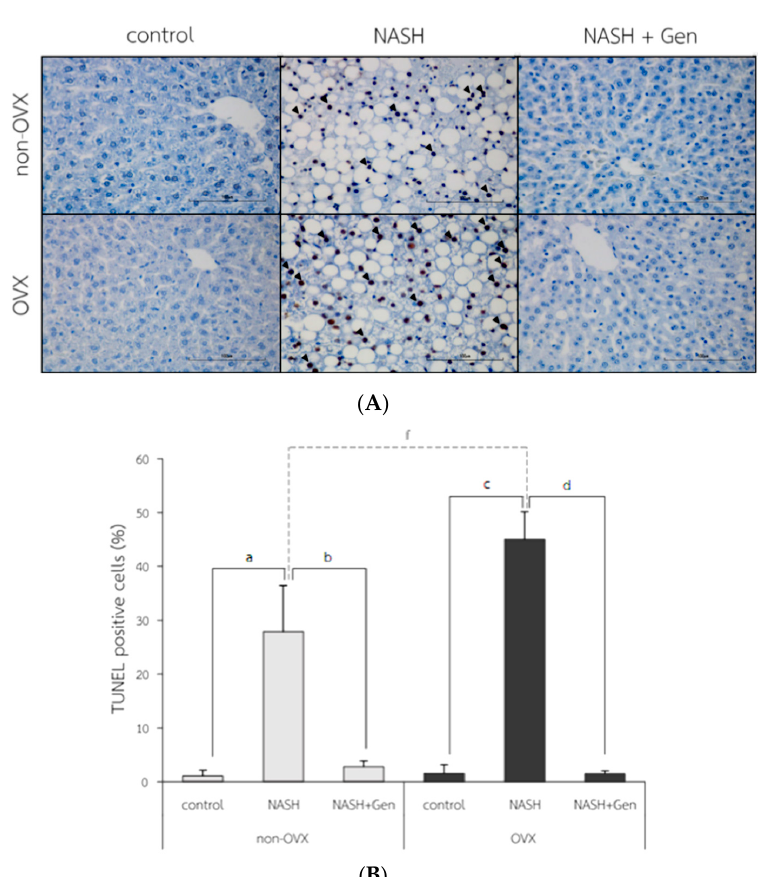
Figure 7. TUNEL positive cells in liver tissue. ( A ) the representative images of hepatocyte apoptosis in liver sections. Arrows indicate TUNEL positive cells. The original magnification is 400 × . ( B ) The percentage of TUNEL positive cells. a: p < 0.05 comparison between control and NASH groups of non-OVX rats. b: p < 0.05 comparison between NASH and NASH+Gen groups of non-OVX rats. c: p < 0.05 comparison between control and NASH groups of OVX rats. d: p < 0.05 comparison between NASH and NASH+Gen groups of OVX rats. f: p < 0.05 comparison between NASH groups of non-OVX and OVX rats.